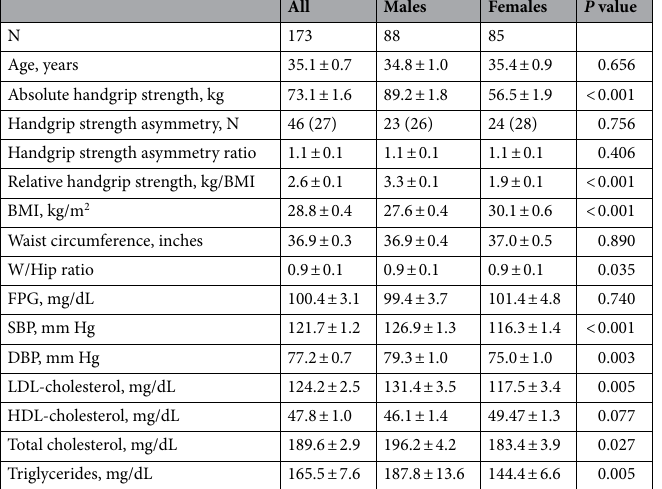
Table 2. Sex-specific clinical characteristics of the Hispanic farmworkers population. Values are mean ± SEM. BMI body mass index, W/Hip waist/hip circumference, FPG fasting blood glucose, SBP systolic blood pressure, DBP diastolic blood pressure, LDL low-density lipoprotein, HDL high-density lipoprotein.